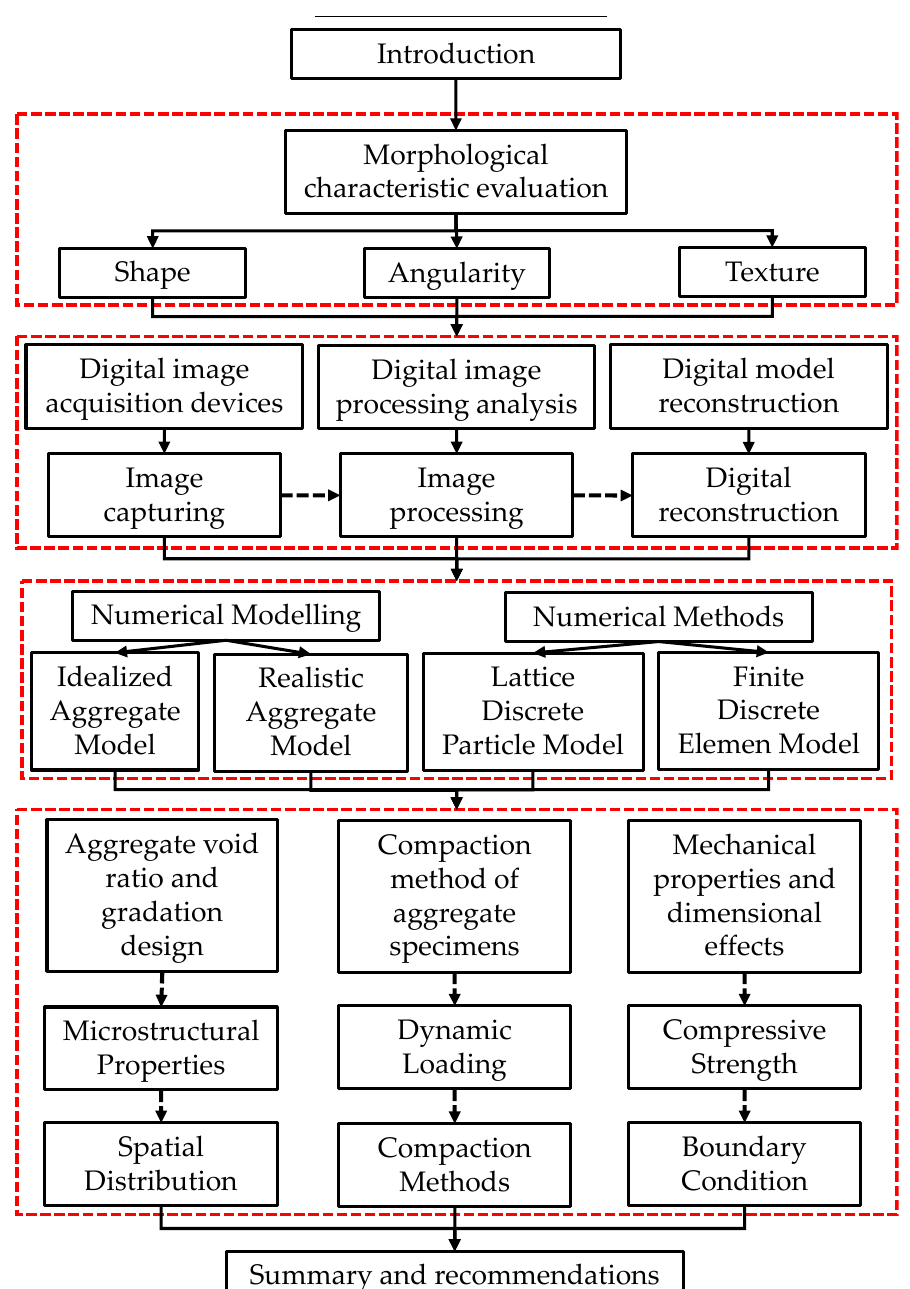
Figure 1. Flowchart of this review.